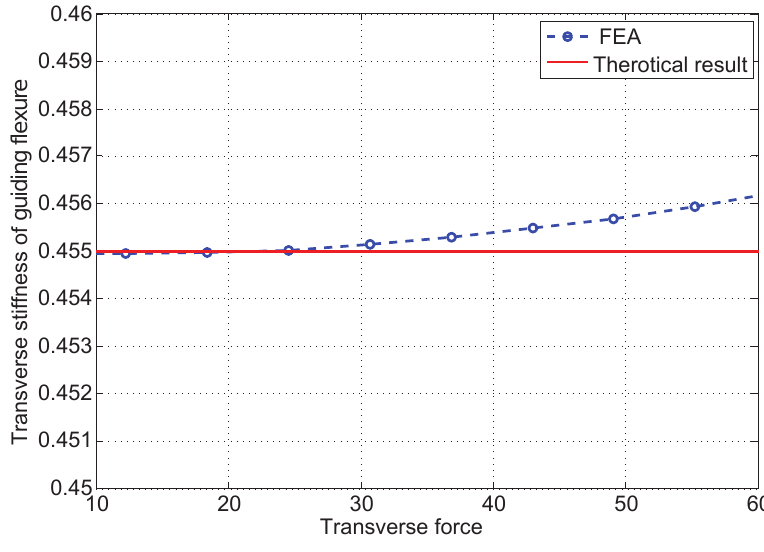
Figure 5. The normalized stiffness of the guiding